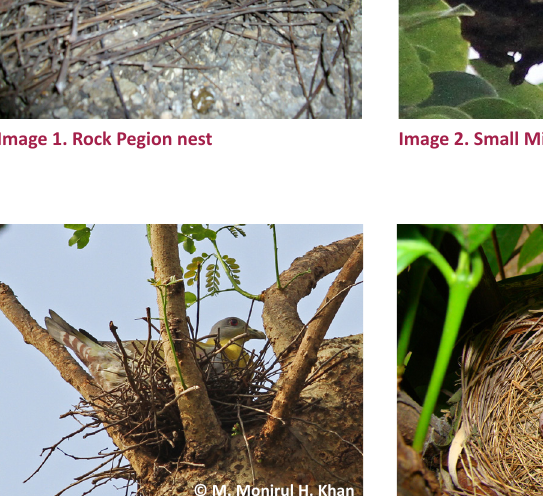
Image 6. Red-wattled Lapwing nest